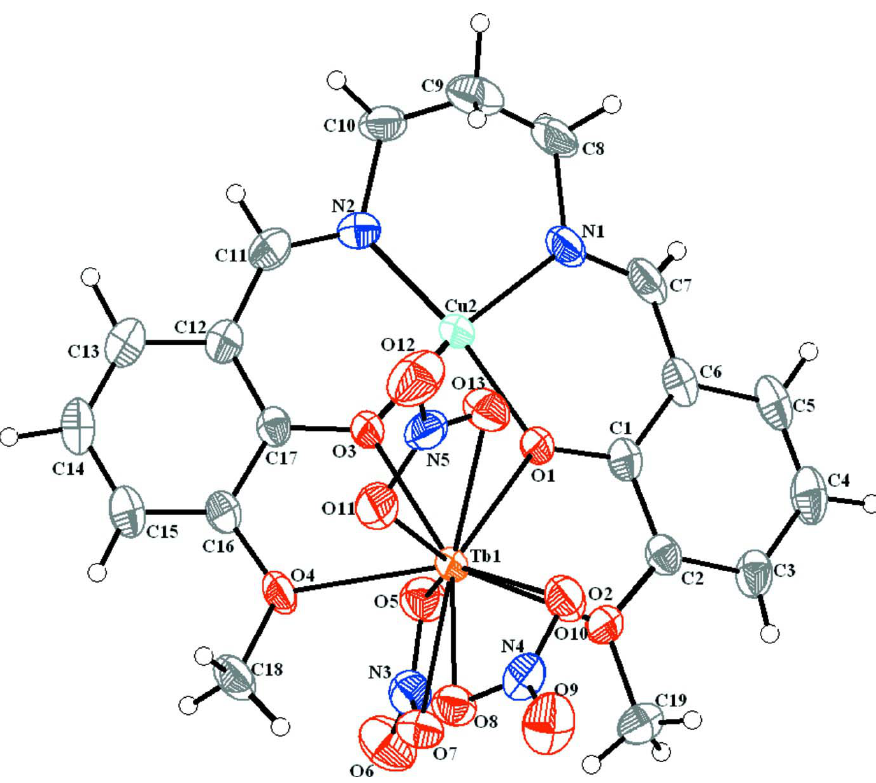
Figure 1 The molecular structure, showing 40% probability displacement ellipsoids for non-H atoms. The acetone solvent molecule is not